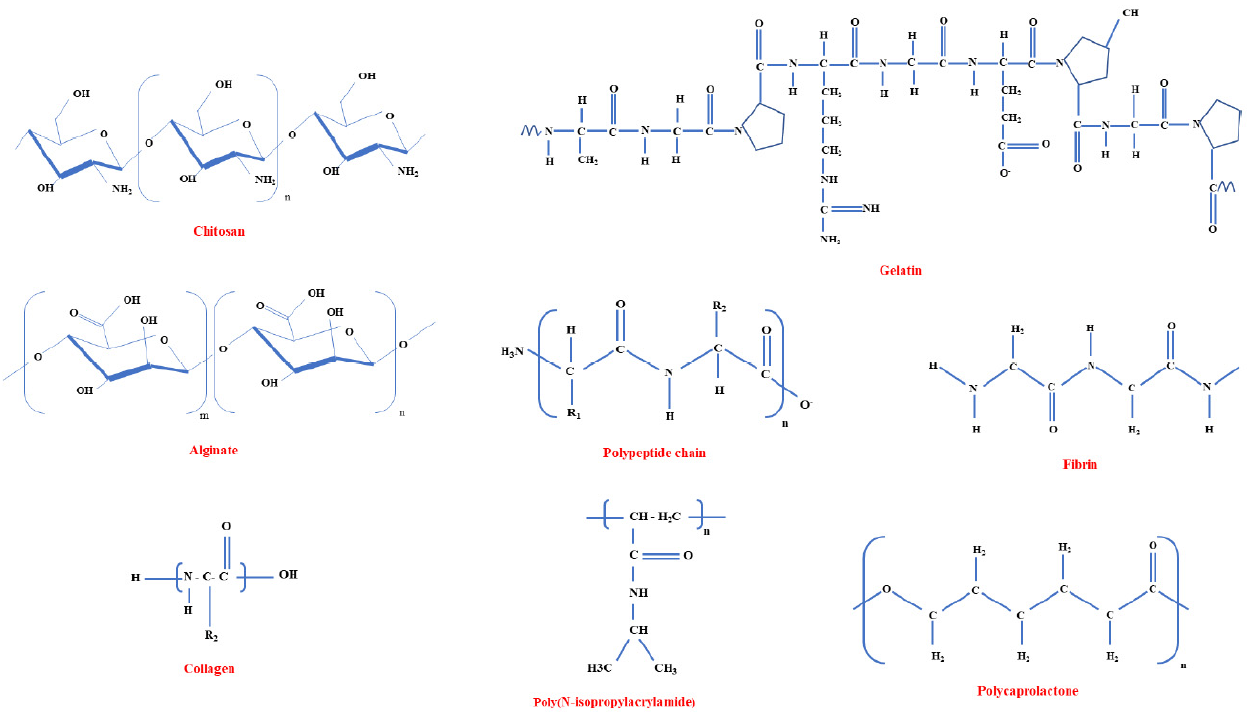
Figure 5. Molecular structures of several injectable hydrogels suitable for cardiac tissue engineering. Adapted from [23] .